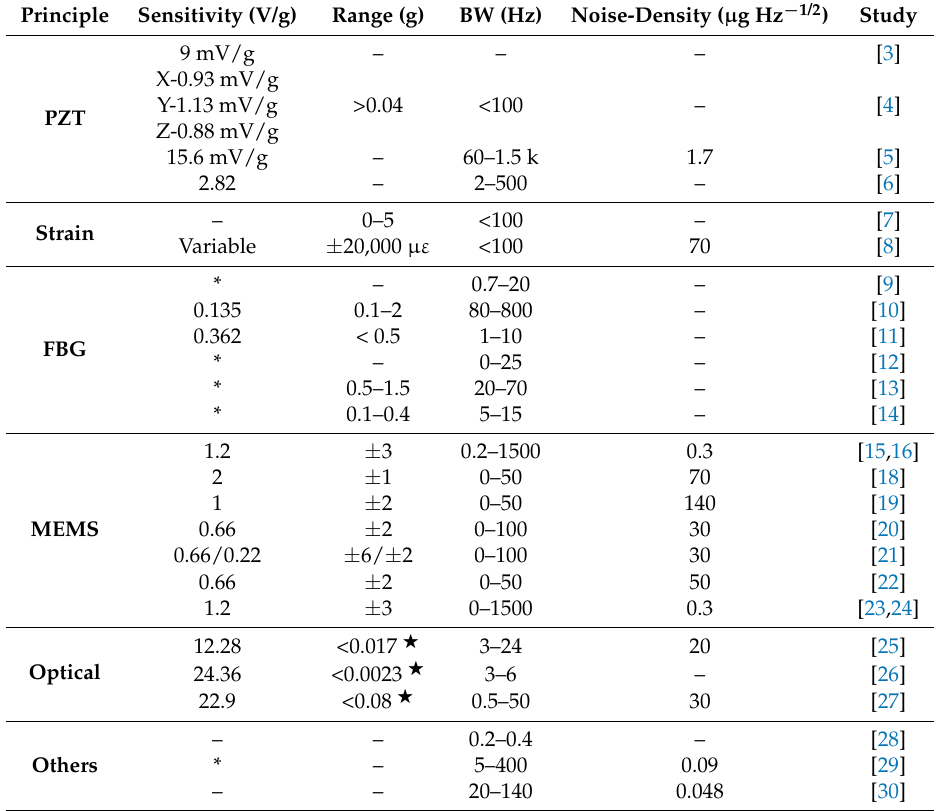
Table 1. Summary of accelerometers of low-frequency micro-vibration. BW: bandwidth; PZT: piezoelectric; FBG: fiber Bragg grating; MEMS: micro-electro-mechanical